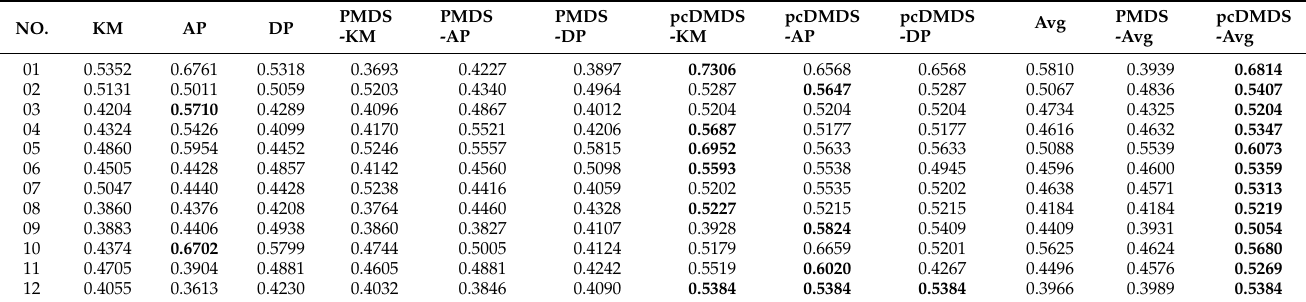
Table 2. Accuracy of clustering with different data representations.